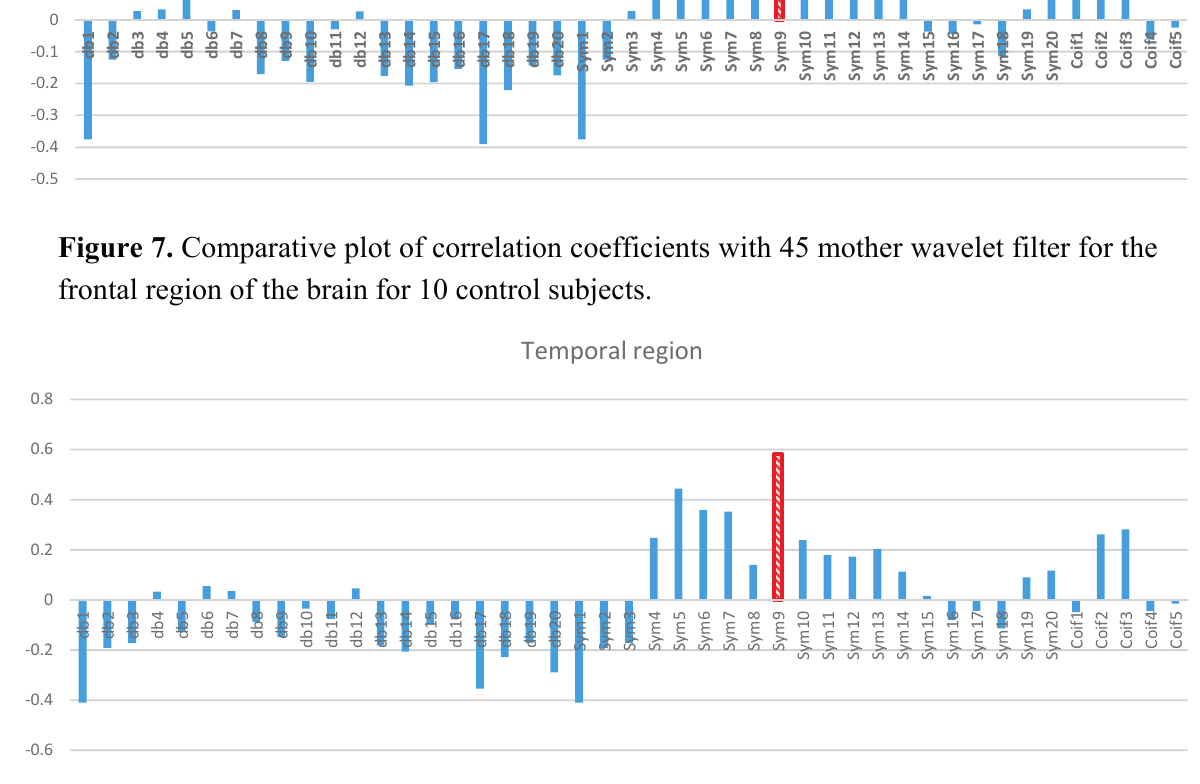
Figure 8. Comparative plot of correlation coefficients with 45 mother wavelet filter for the temporal region of the brain for 10 control subjects.